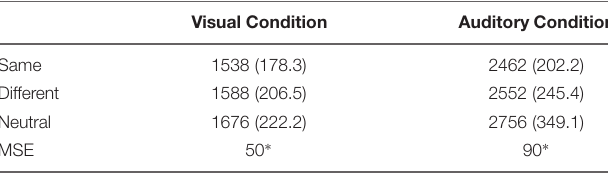
TABLE 1 | Mean Response Time (RTs) (in Milliseconds) with Standard Deviations in parenthesis, as a Function of Modality (same, different, neutral) for both visual and auditory conditions.